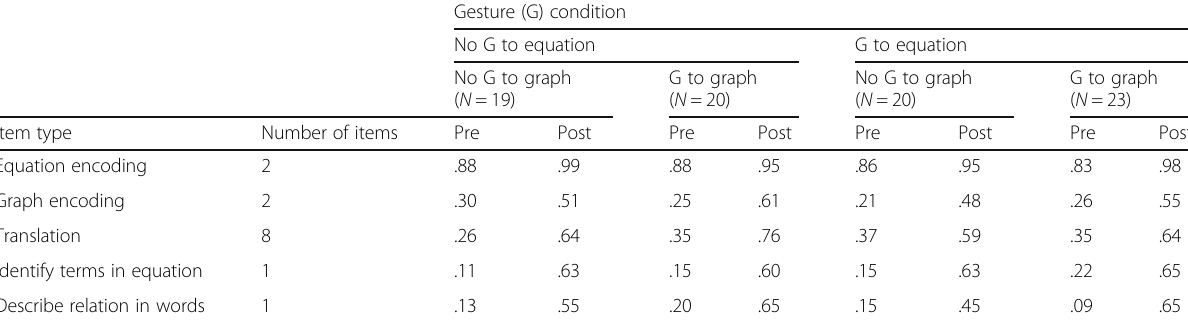
Table 1 Average proportion correct at pretest and posttest in each gesture condition and for each type of assessment